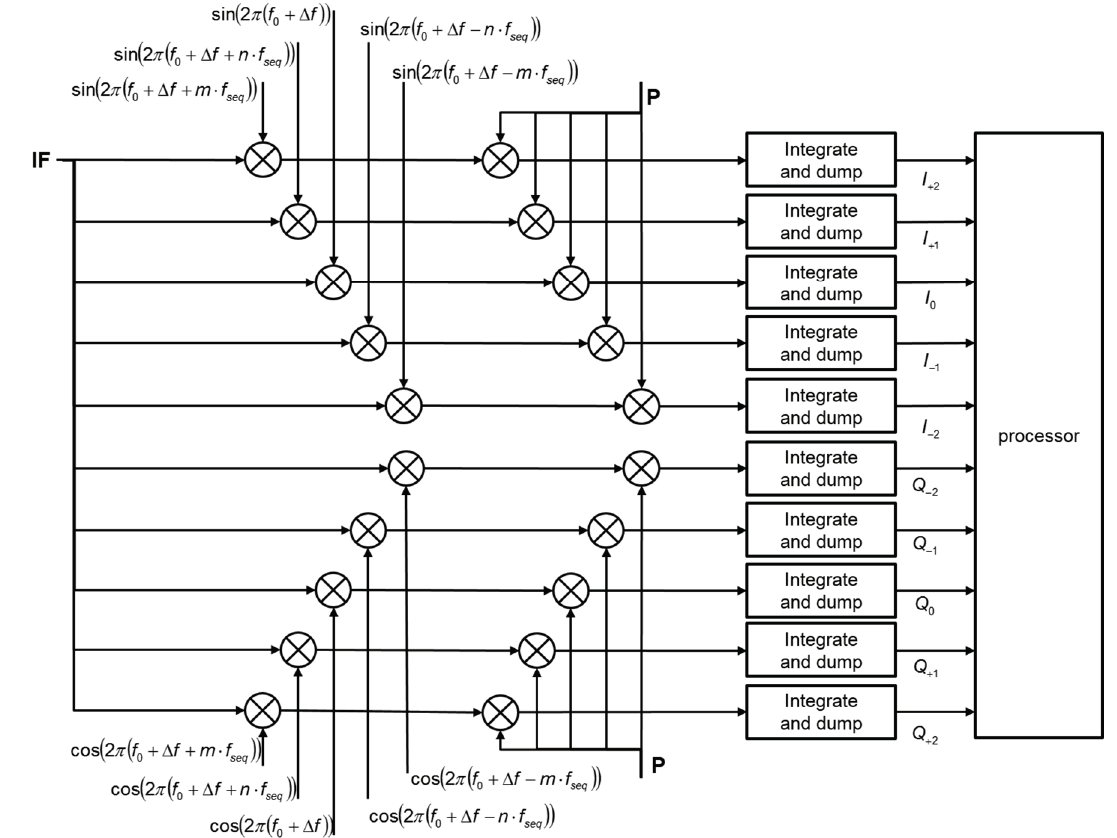
Figure 9. Channel block diagram for the false lock detection.